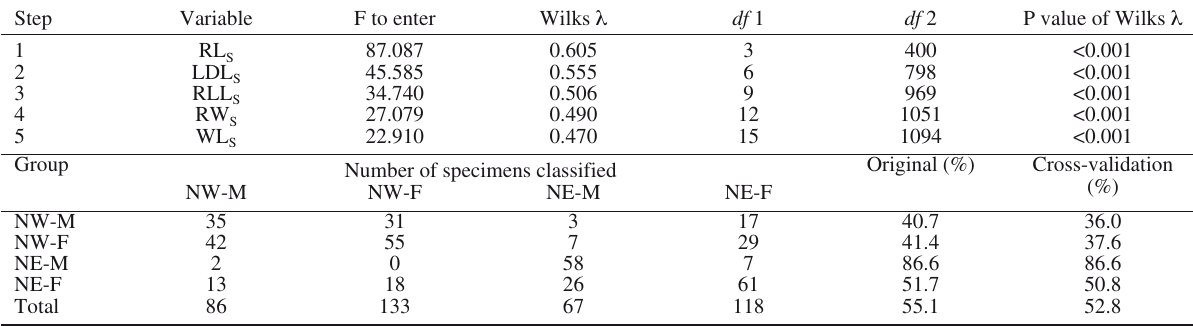
Table 6. – The results estimated from stepwise discriminant analysis of standardized statolith variables for each sex of two populations, and a classification matrix with percentages of correctly classified individuals and cross-validation results.